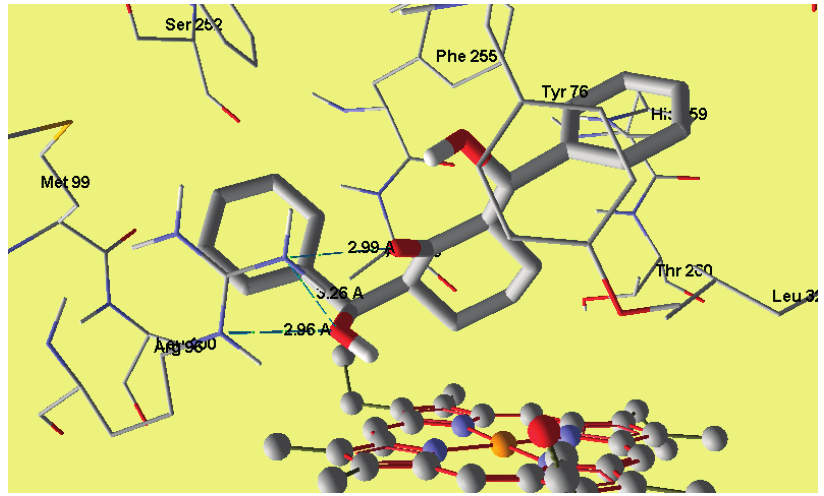
Figure 13. Interaction of compound 1 with the active site of cytochrome P450 14 α -sterol